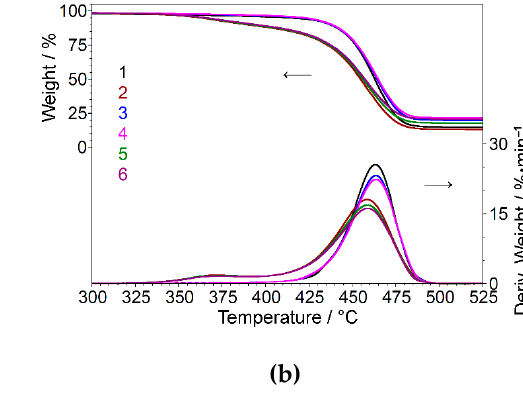
Figure 9. TGA analysis for PPW/SBSBC/n-Clay composites (PPW (1), PPW/SBSBC (2), PPW/n-Clay 5% (3), PPW/n-Clay 10% (4), PPW/SBSBC/n-Clay 5% (5), PPW/SBSBC/n-Clay 10% (6)) ( a ) and PPW/SISBC/n-Clay composites (PPW (1), PWP/SISBC (2), PWP/n-Clay 5% (3), PPW/n-Clay 10% (4), PPW/SISBC/n-Clay 5% (5), PPW/SISBC/n-Clay 10% (6)) ( b ).